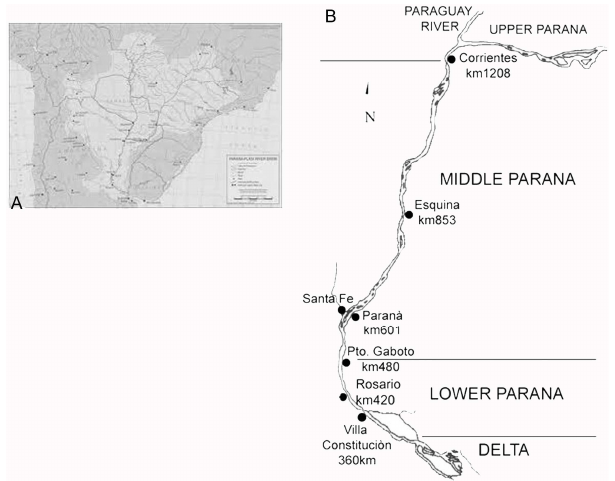
Figure 2. (A) La Plata Basin. (B) The middle and lower Paraná with the principal cities and corresponding kilometric labelling of the water way.